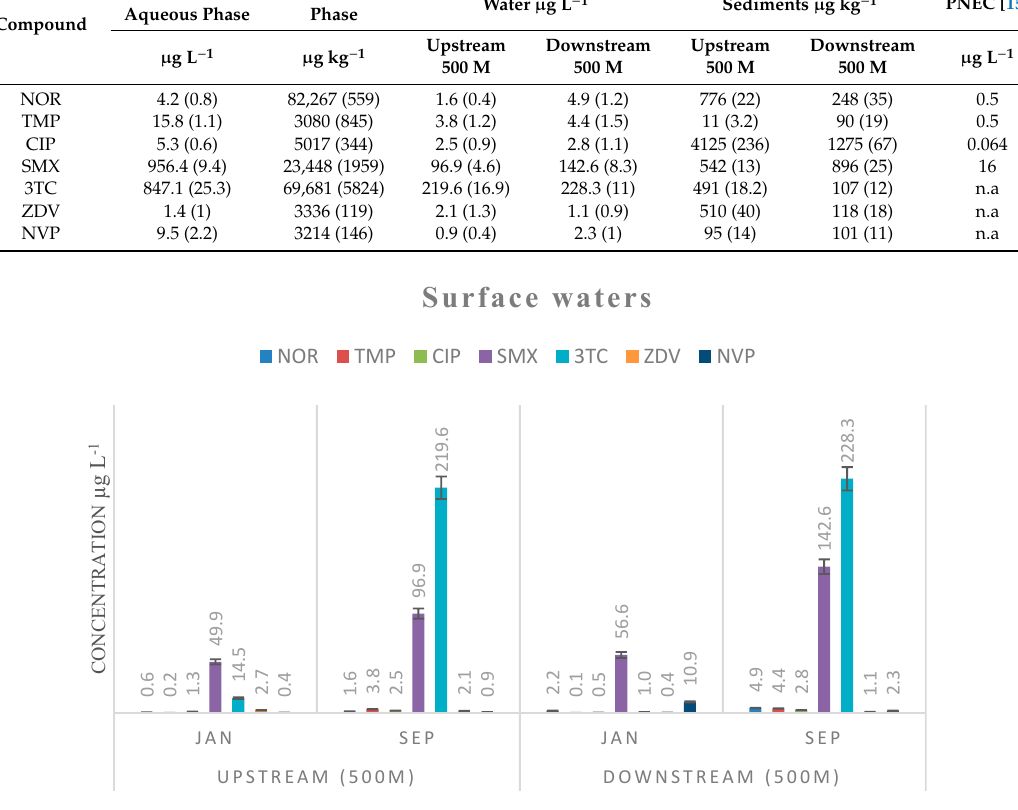
Figure 1. Seasonal variation of APIs in surface waters.